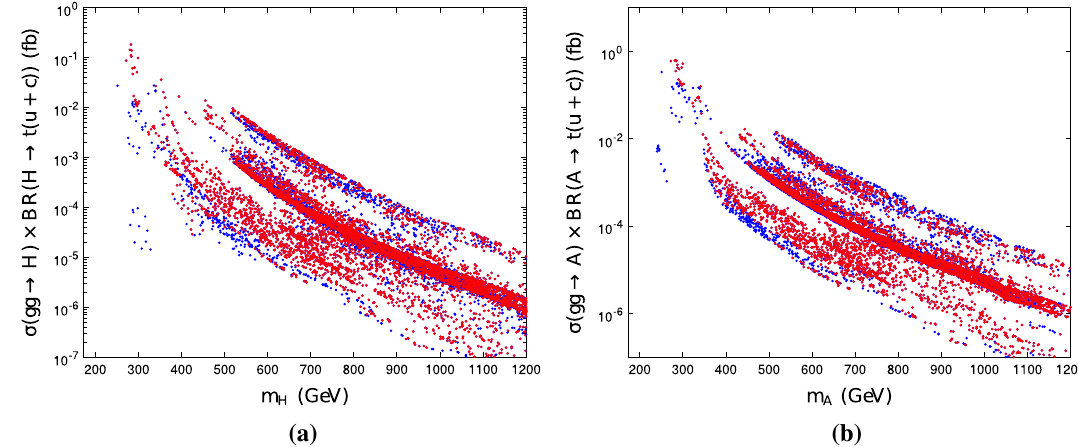
Fig. 6 a The gluon–gluon production and the decay to tq of a the pseudoscalar A and b the heavy CP -even scalar H versus their respective masses. The colour code is the same as in the previous